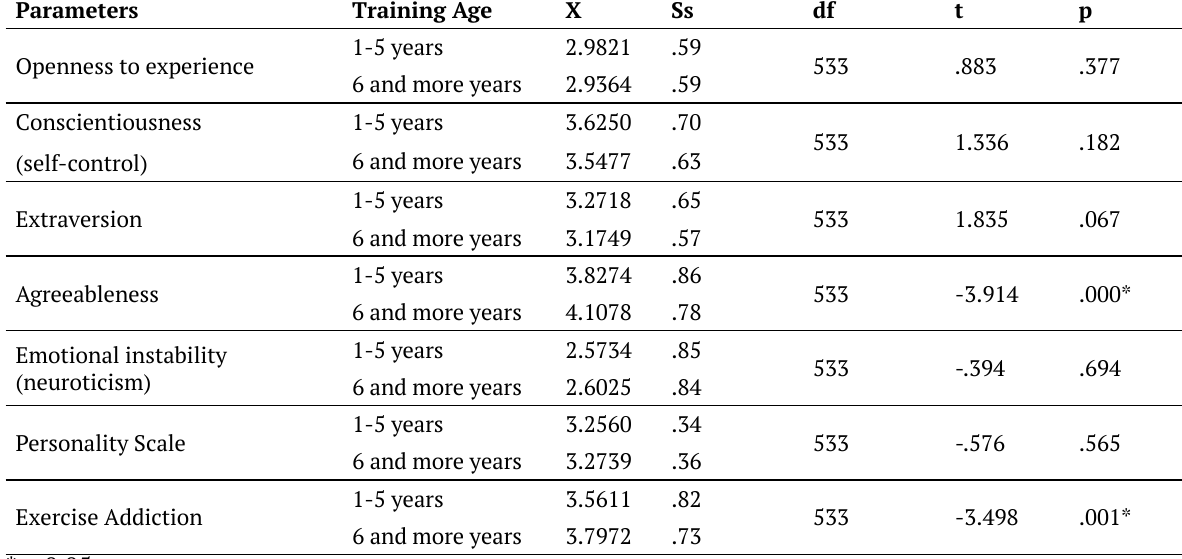
Table 3. T-test results of students’ exercise addiction and personality based on training age Parameters